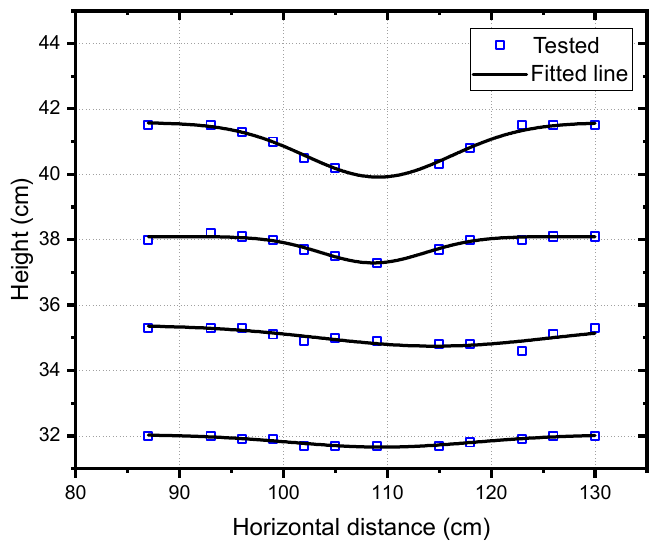
Figure 6. Gaussian fitting of the T1 energy levels.